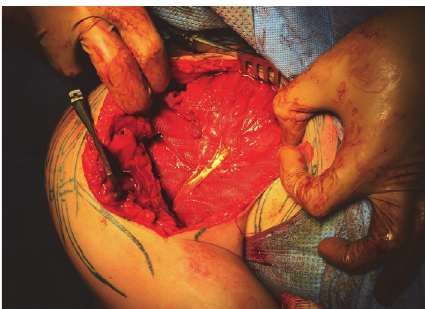
Figure 5: Intraoperative photograph, with the free border of the graft sutured at the PM.